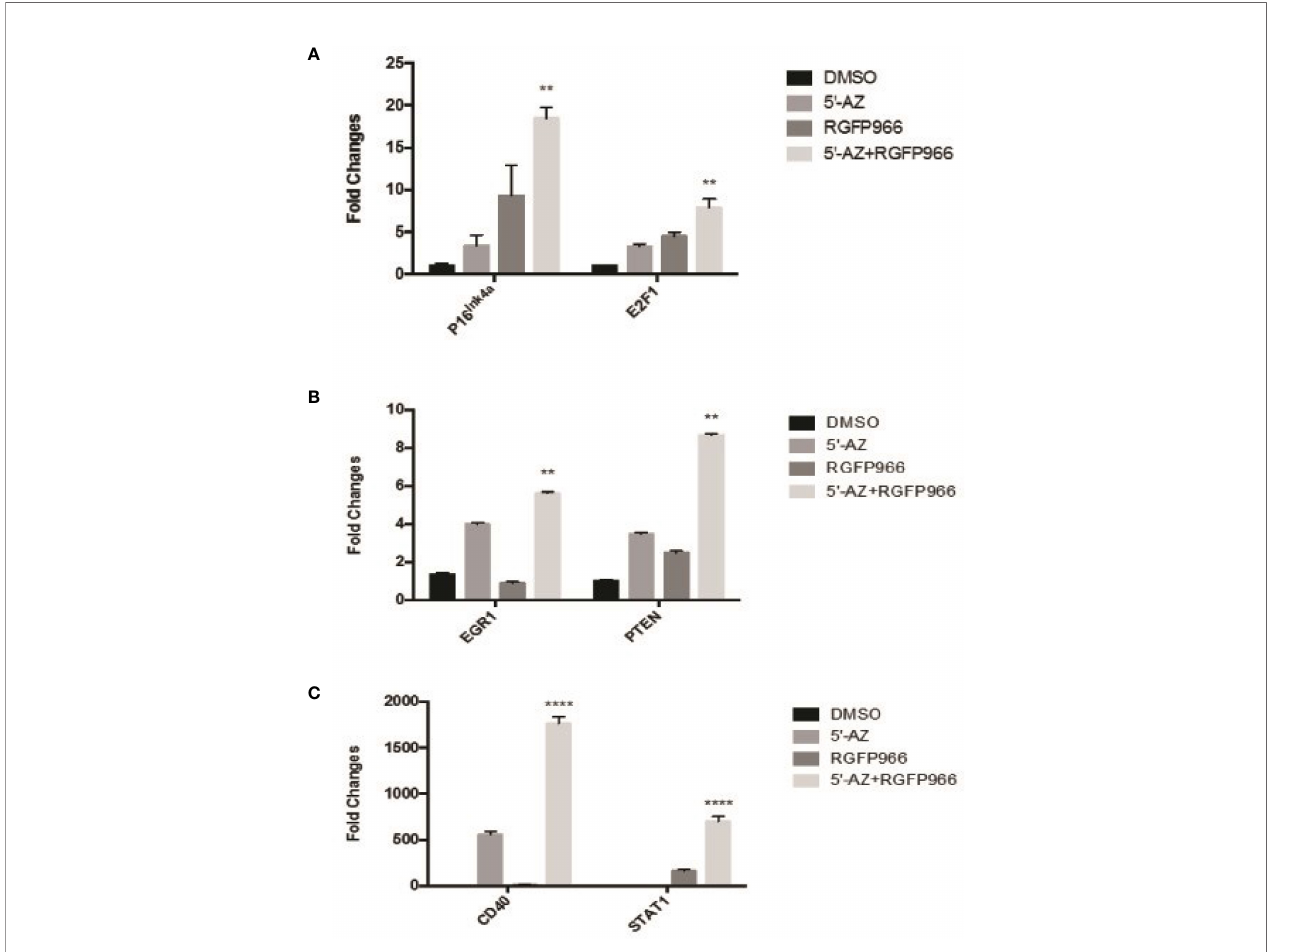
FIGURE 5 | The expression of tumor suppressors induced by HDAC3 and 5 ’ -AZA. (A) Induction of E2F1, P16 Ink4a by 5 ’ -AZA and RGFP966. (B, C) : The expression of EGR1 and PTEN (B) , and CD40 and STAT1 (C) induced by 5 ’ -AZA and RGFP966. **p < 0.001, ****p <